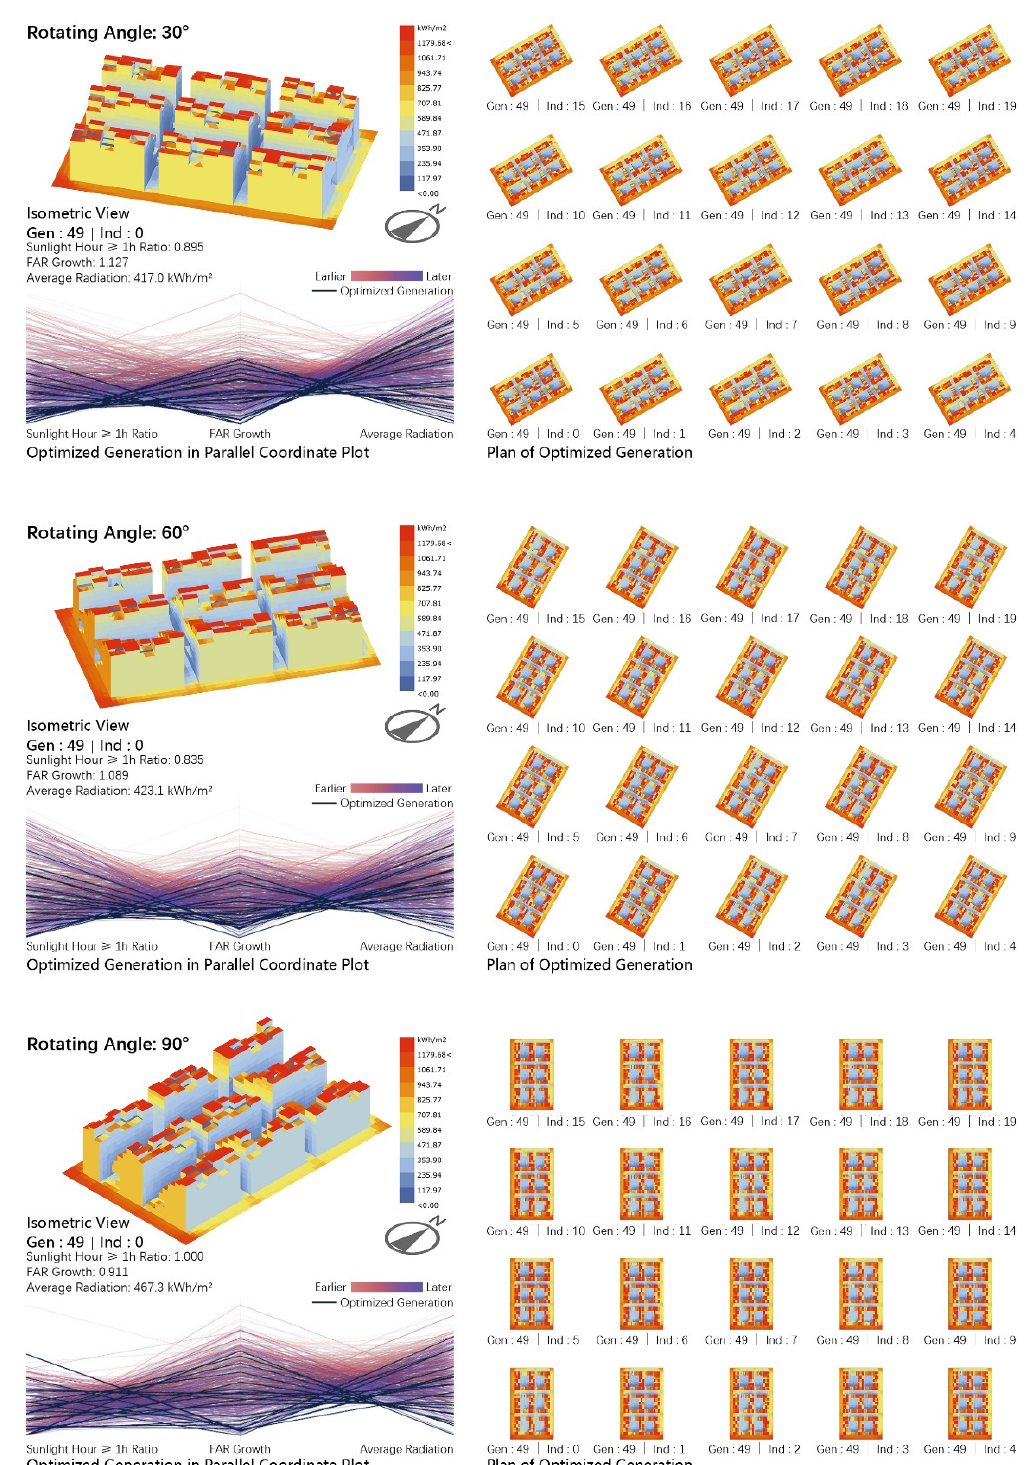
Figure 13. Solutions of the mixed addition mode for the varied orientations.